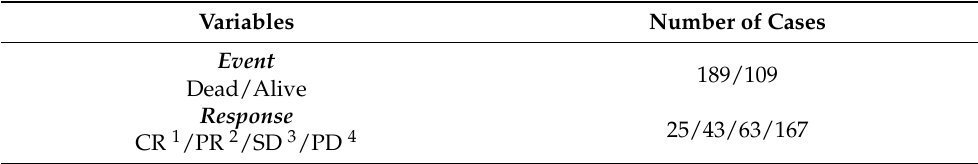
Table 3. Characteristics of patients in